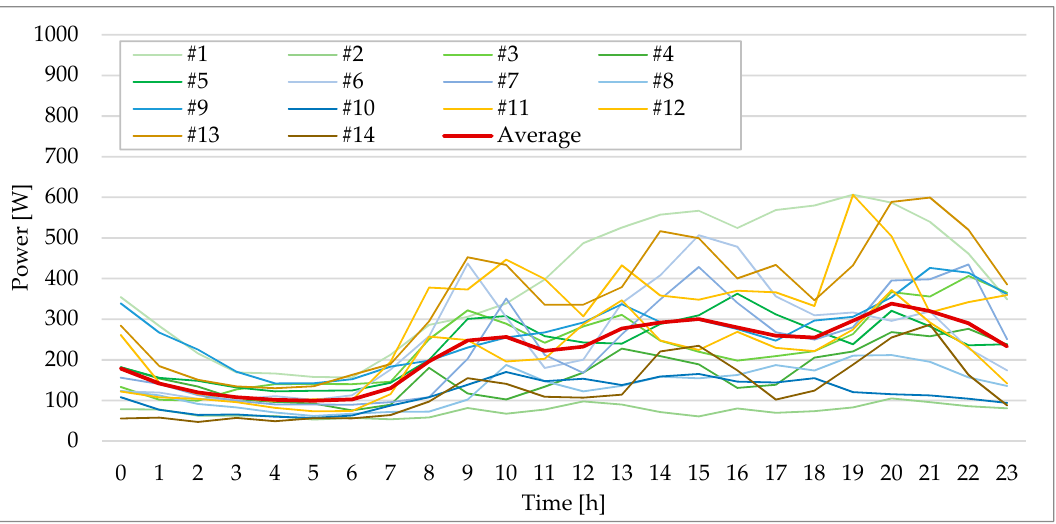
Figure 7. Archetypes average daily profiles over the Saturdays.